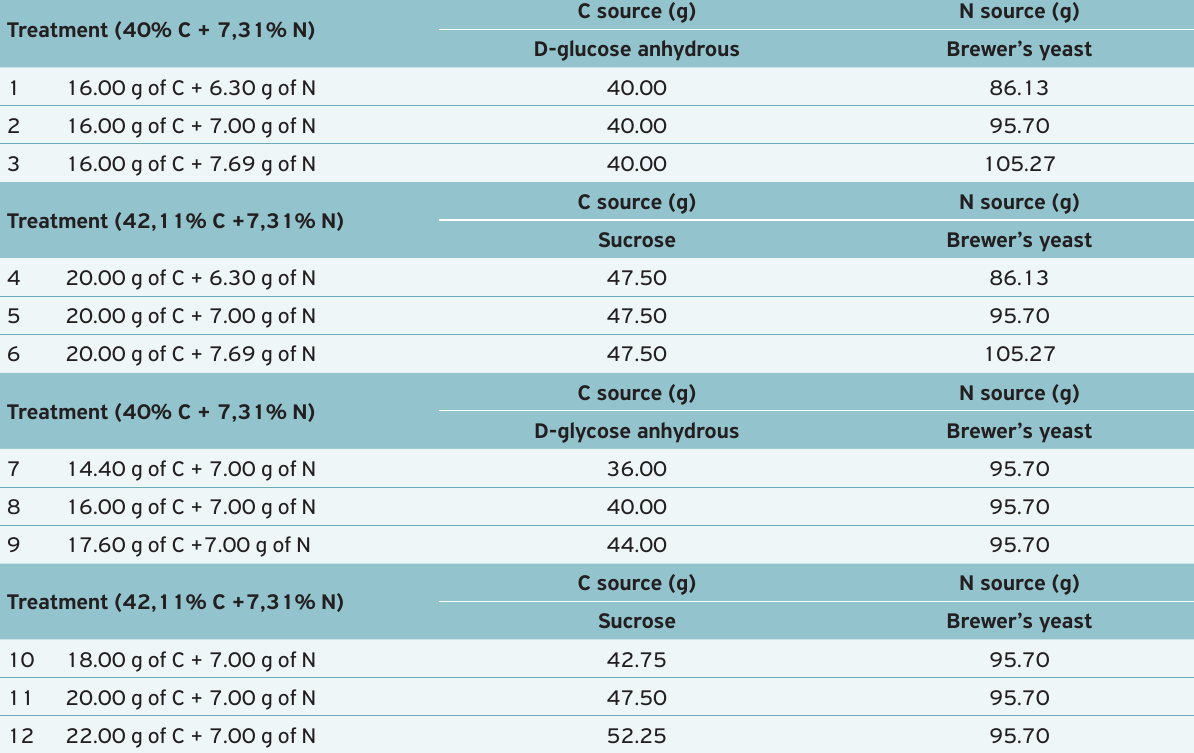
Table 1. Amounts of carbon and nitrogen sources to prepare 1.0 L of each culture